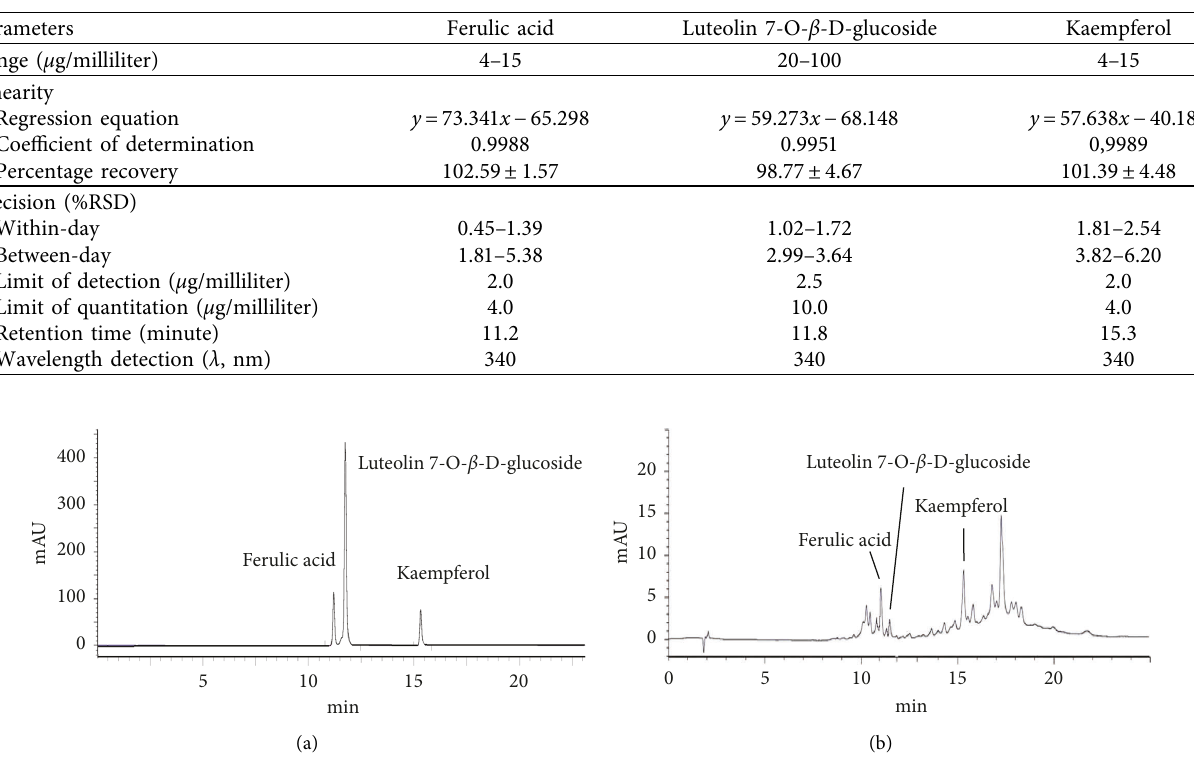
Table 2: Validation results of the analysis of ferulic acid, luteolin 7-O- β -D-glucoside, and kaempferol in the W. globosa extract by the HPLC method.